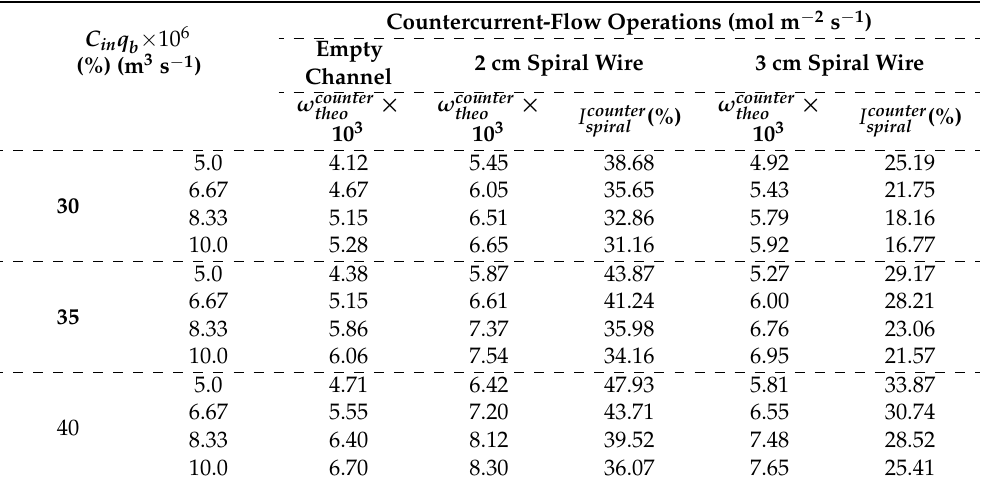
Table 3. Effects of spiral-wire pitches on absorption flux